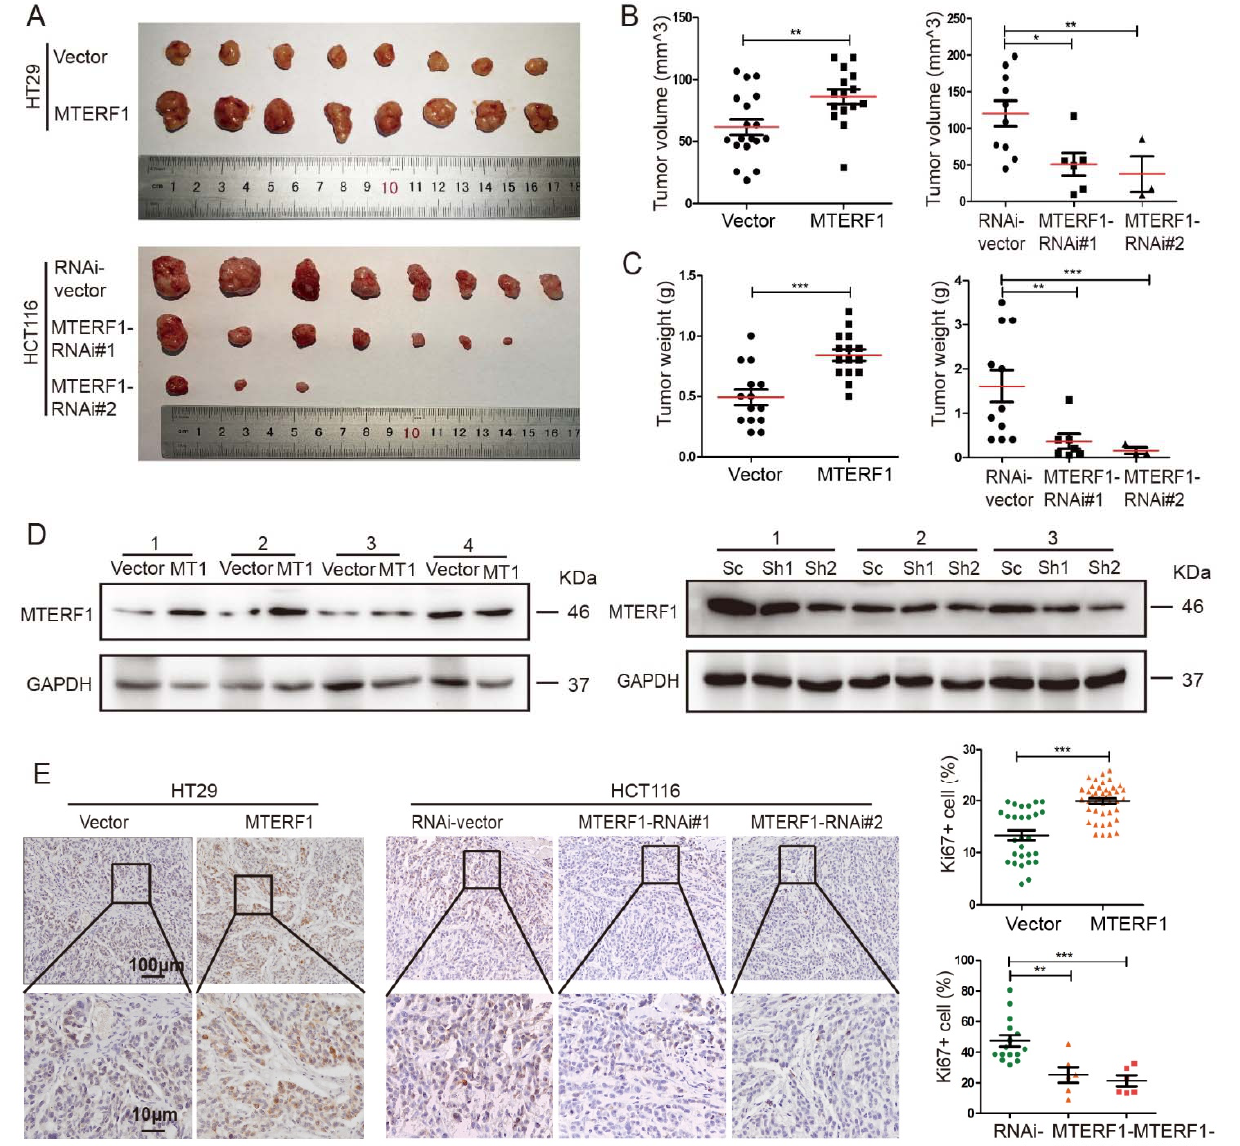
Figure 3. MTERF1 is beneficial to xenograft tumor formation in vivo. ( A ) Upregulation of MTERF1 (MTERF1) promoted xenograft tumor formation, while downregulation of MTERF1 inhibited xenograft tumor formation in vivo. ( B , C ) Quantitative analysis of xenograft tumor volume ( B ) and weight ( C ). ( D ) Detection of MTERF1 expression in xenograft tumor samples by Western blotting analysis. V: Vector; MT1: MTERF1; Sc: RNAi ‐ vector; Sh1: MTERF1 ‐ RNAi#1; Sh2: MTERF1 ‐ RNAi#2. GAPDH was used as an internal control. ( E ) Representative images of Ki67 IHC and quantification data for xenograft tumor sections. Scale bar: 100 μ m. Scale bar: 25 μ m. Data are presented as the means ± SEM (n ≥ 3). * p < 0.05, ** p < 0.01, *** p < 0.001 by two ‐ tailed Student’s t ‐ test.